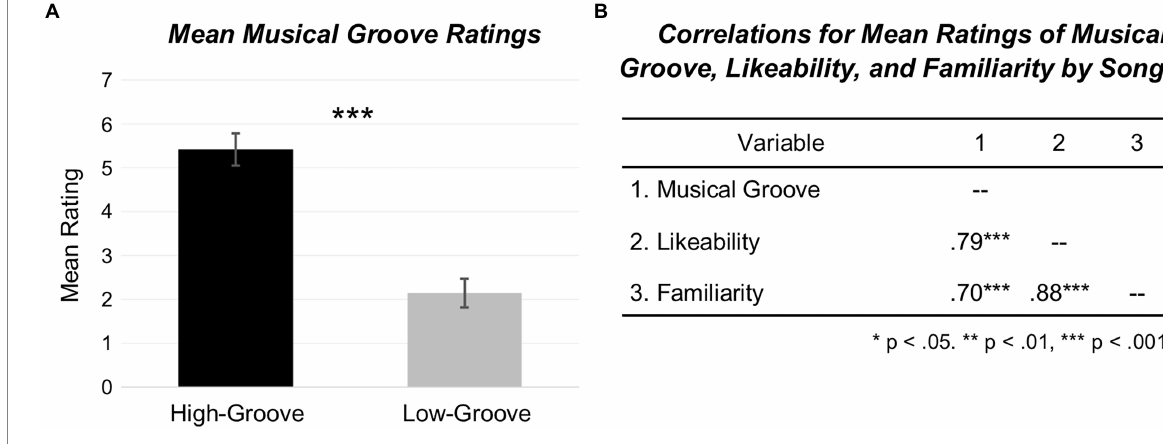
FIGURE 1 Mean musical groove ratings and correlations for musical groove, likeability, and familiarity. (A) Bar graphs of mean musical groove ratings ( N = 20; high-groove = 10, low-groove = 10) based on musical excerpt as a case (i.e., data averaged across participants for each excerpt). Error bars indicate 95% confidence intervals. Results reveal statistically significant differences between high-groove (black) and low-groove (grey) mean song ratings F 1,18 = 226.02, p < 0.001. (B) Relationships between mean musical groove ratings, mean likeability ratings, and mean familiarity ratings ( N = 20; high- groove = 10, low-groove = 10). Results show statistically significant positive correlations between musical groove and likeability ratings, musical groove and familiarity ratings, and likeability and familiarity ratings.